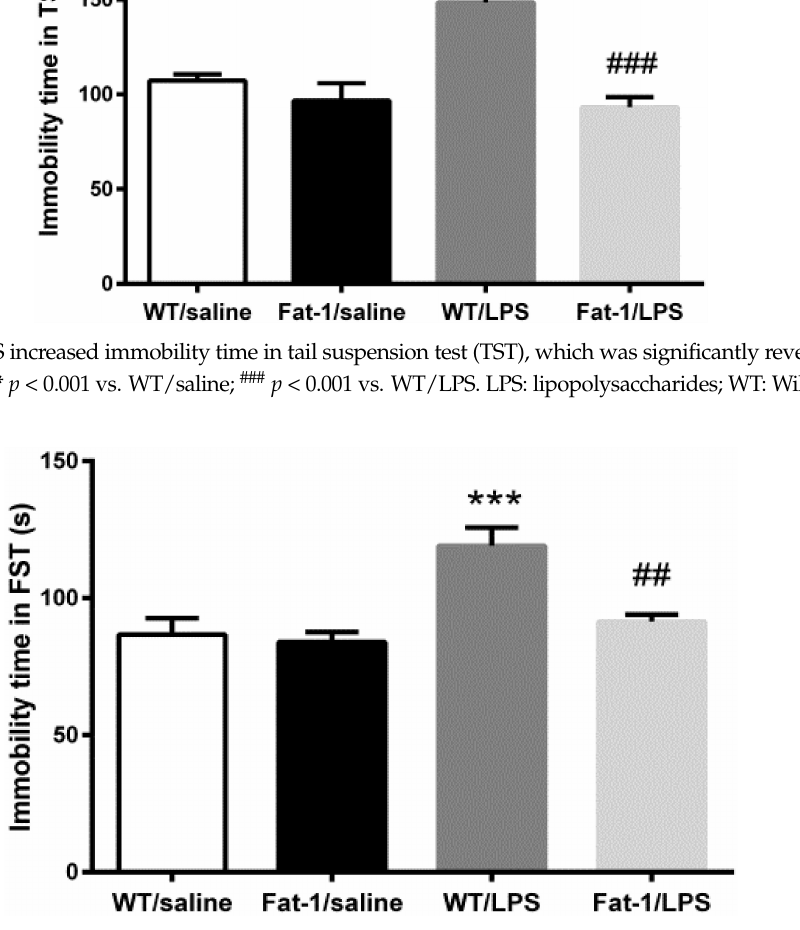
Figure 4. LPS increased immobility time in forced-swimming test (FST), which was attenuated in Fat-1 mice. *** p < 0.001 vs. WT/saline; ## p < 0.01 vs. WT/LPS. LPS: lipopolysaccharides; WT: